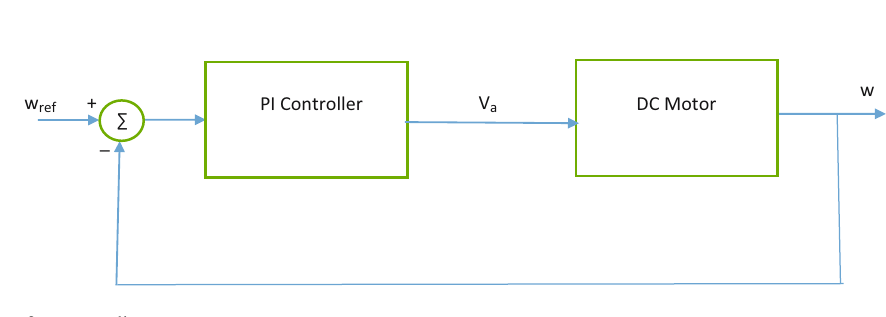
Figure 2: Diagram of PI controller.